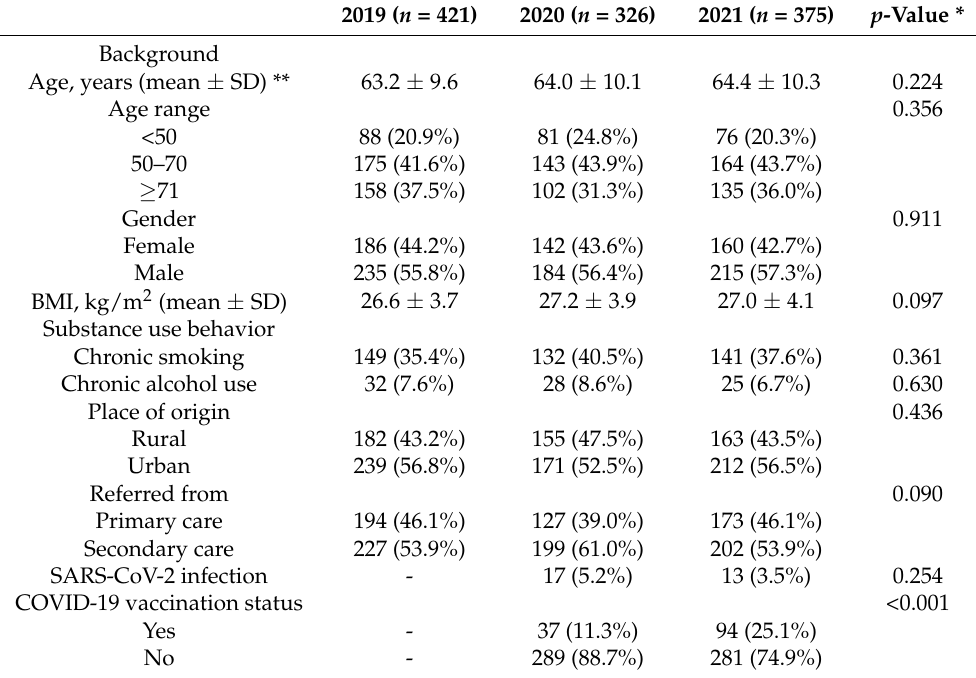
Table 1. Background of patients with urothelial carcinoma sorted by the year of diagnosis and